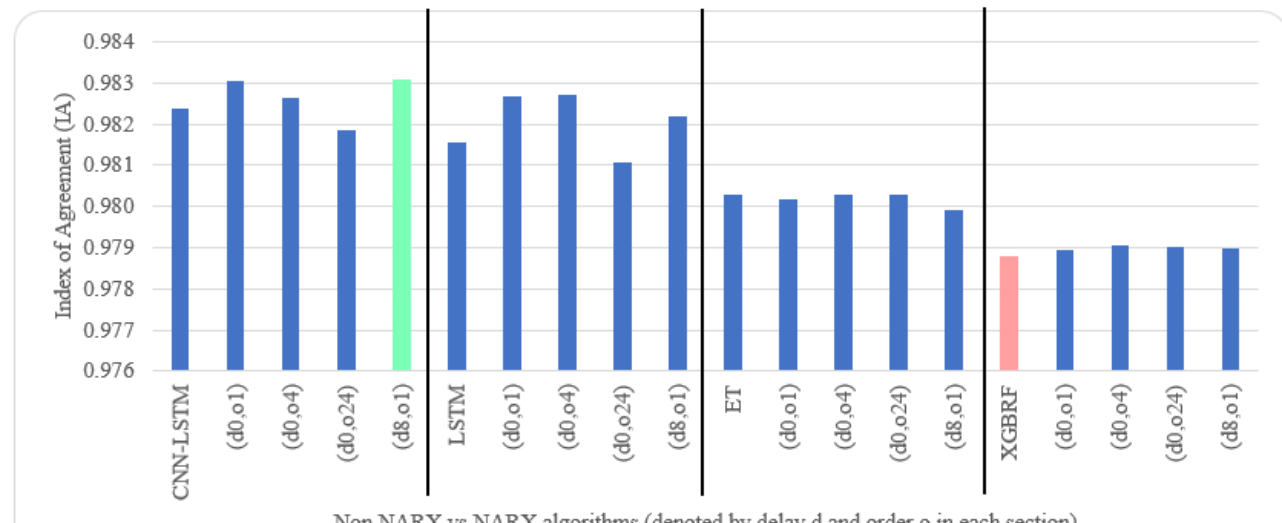
Figure 23. Evaluation results of non-NARX and NARX in terms of index of agreement for the Beijing dataset.